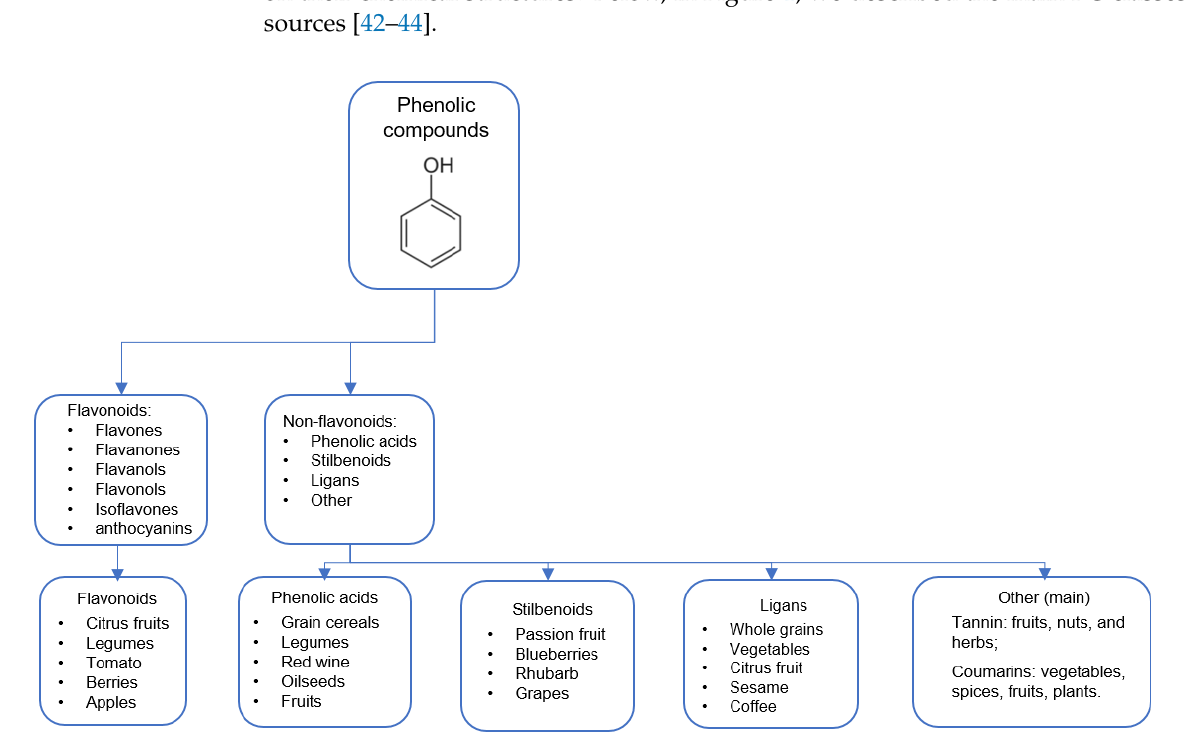
Figure 1. Phenolic compounds and